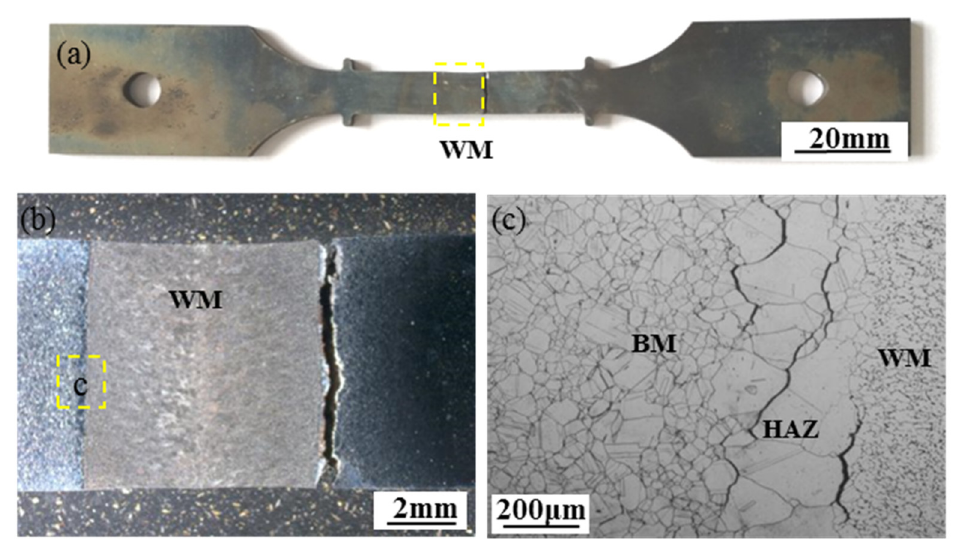
Figure 4. Fracture morphology of the creep rupture specimens at 600 ◦ C under 238 MPa stress for 430 h: ( a , b ) macroscopic morphology of the creep fracture; ( c ) amplified fracture of HAZ.